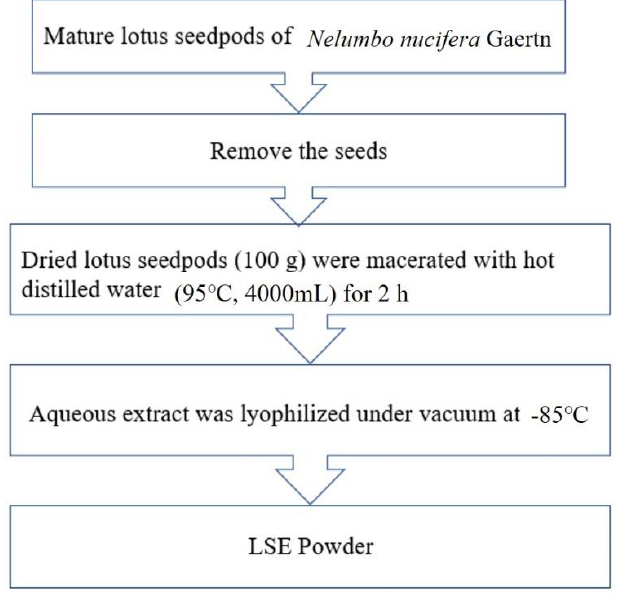
Figure 6. LSE preparation process. The dried lotus seedpods ( Nelumbo nucifera Gaertn.) (100 g) were macerated with hot distilled water (95 °C, 4000 mL) for 2 h. The decoction was filtered and lyophilized as lotus seedpods extract powder (LSE).